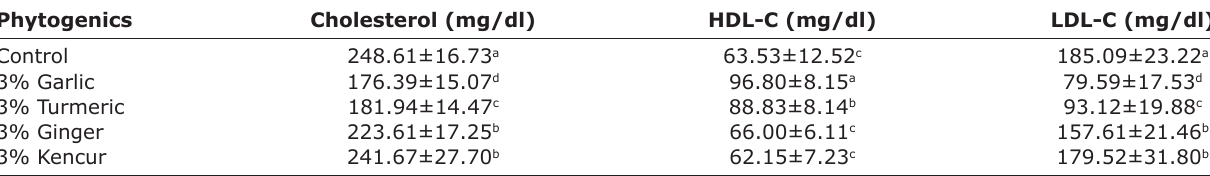
Table-3: Effect of phytogenics supplement on cholesterol